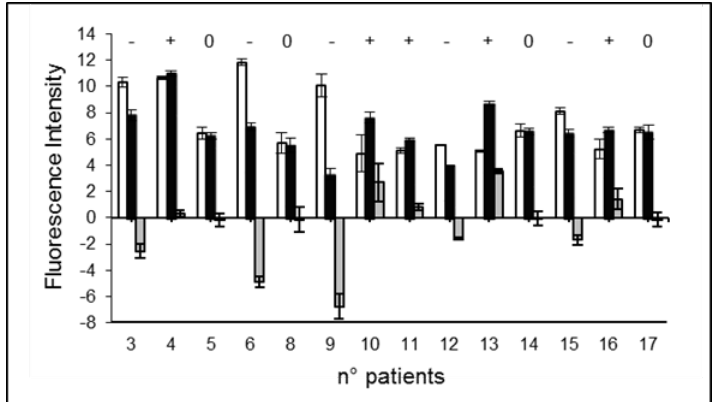
Figure 2. Phosphorylation intensity modulation due to the PBL exposure to the CD (4 Gy) before (white bar) and after (black bar) the I-131 treatment. The third bar represents its difference (delta). Patients marked “+” or “−” showed an increased or decreased responsiveness, respectively, in a statistically significant way; patients marked “0” do not show significant changes. Error bars represent the propagation of the errors.